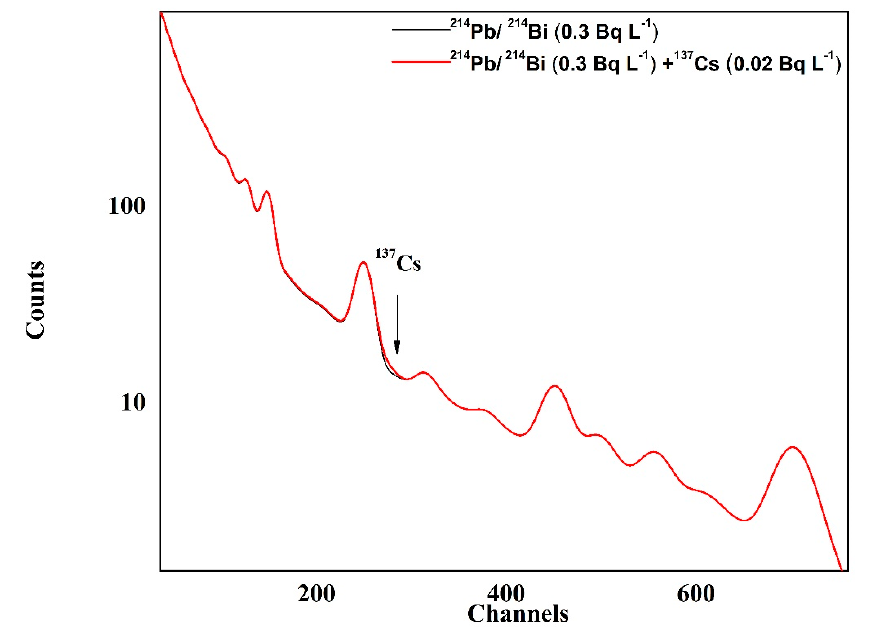
Figure 7. The simulated spectrum (at the energy range from threshold to 1000 keV) after the rain on 21 November 2019 (3 h spectrum with activity concentration of radon progenies 0.3 Bq L − 1 ) and the 137 Cs contribution of 0.02 Bq L − 1 .